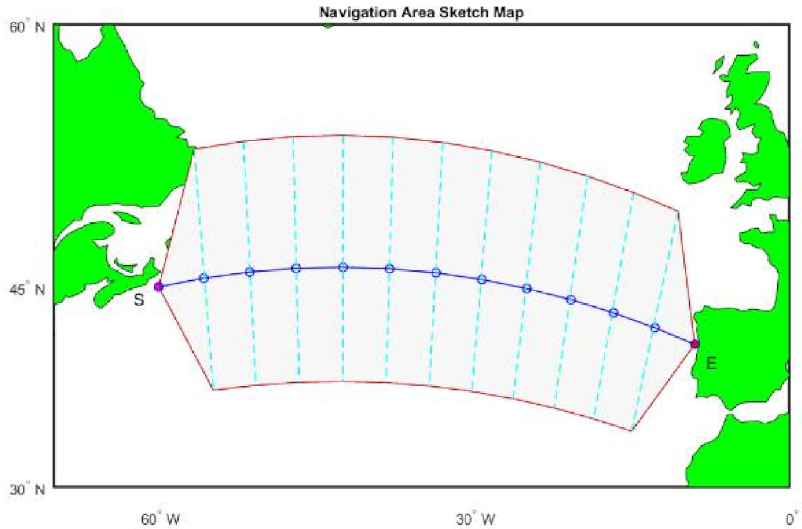
Figure 3. Expansion area. The great circle route is the reference route. Here, Up i and Low i represent the position coordinates of the upper boundary point and the lower boundary point, respectively. Individuals are randomly generated according to a uniform distribution to make the initial population evenly distributed in the entire solution space and increase the diversity of the initial population according to Equation